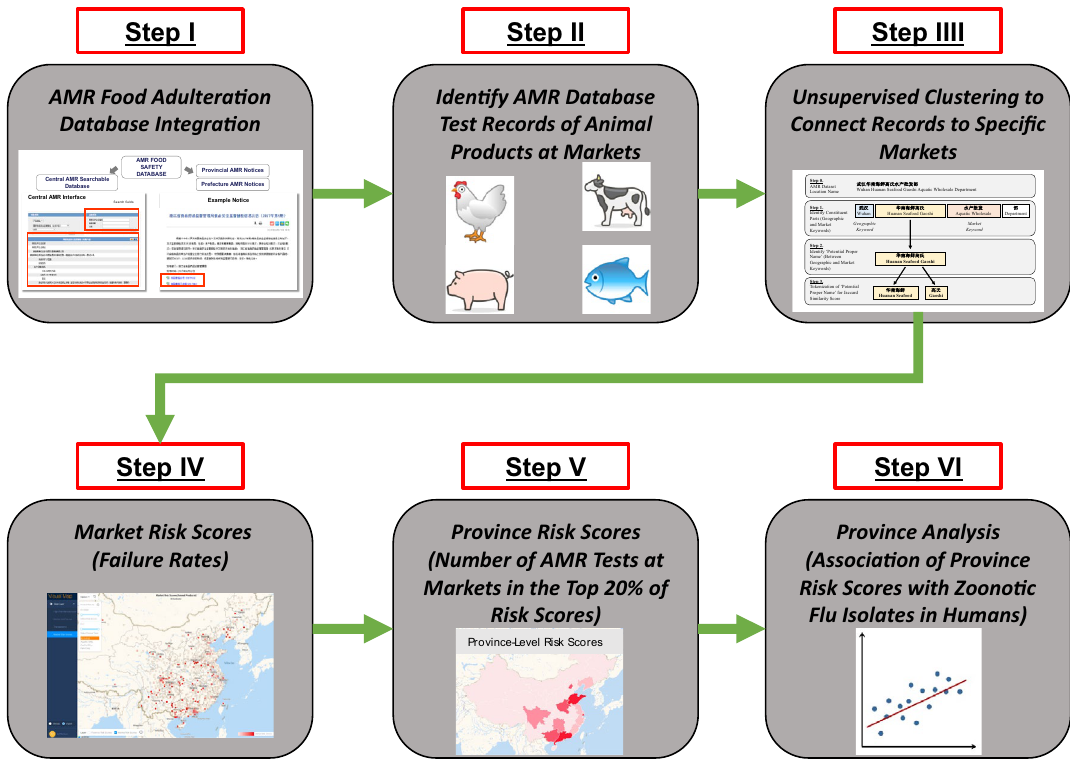
Figure 1. Overview of the risk score analysis to evaluate association of province food adulteration risk scores with zoonotic flu isolates found in humans. AMR dataset tests of animals are clustered to specific markets in order to create market level risk scores. These risk scores are then aggregated at the province level, and the association against province-level zoonotic flu isolates in humans is assessed. Full details can be found in the Supplementary Materials. This graph was created by Microsoft